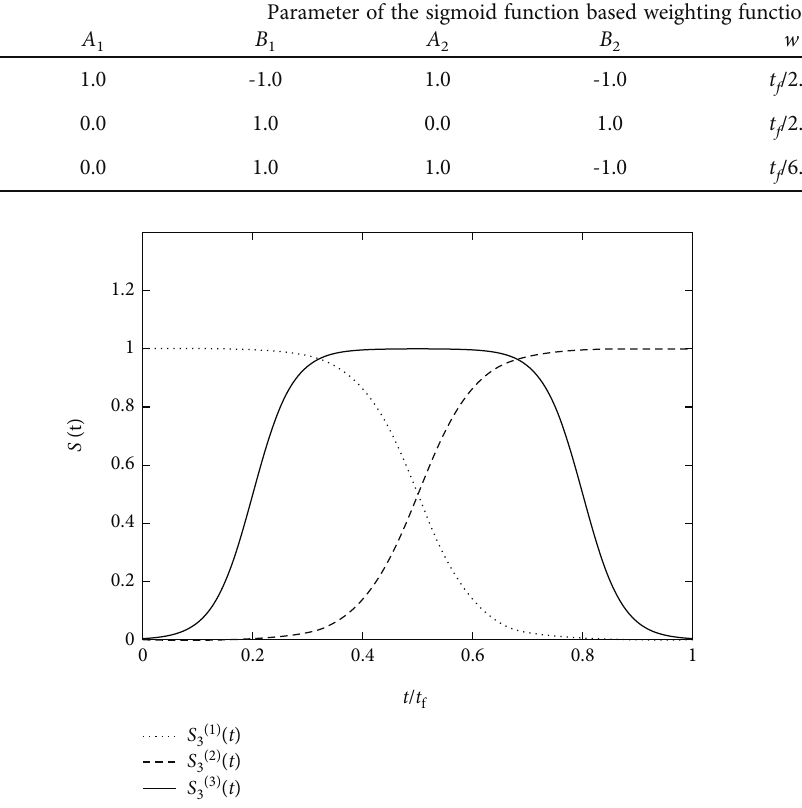
ð t Þ with di ff erent designed 3